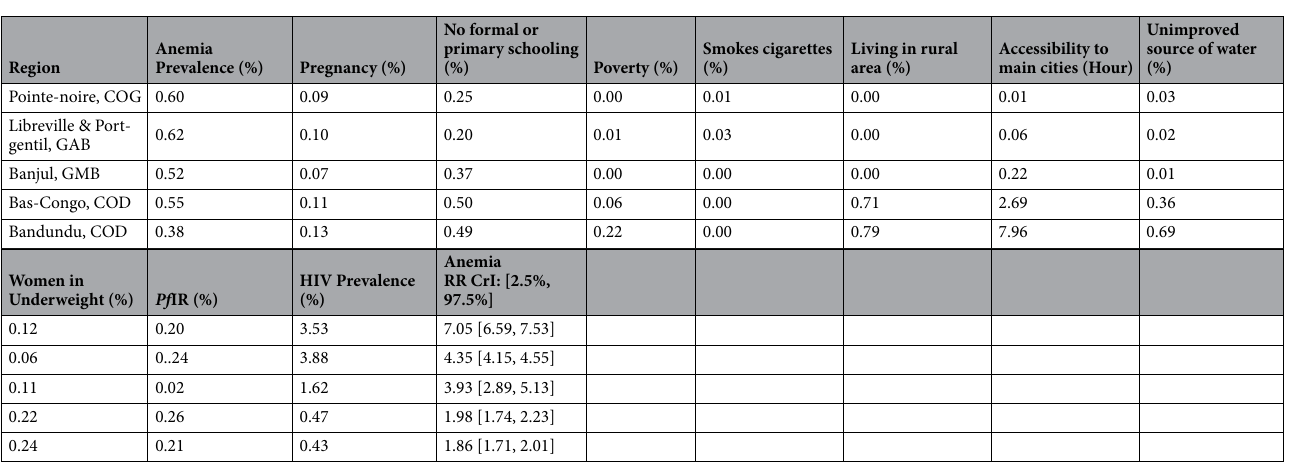
Table 3. Top-five highest risk areas for anemia in